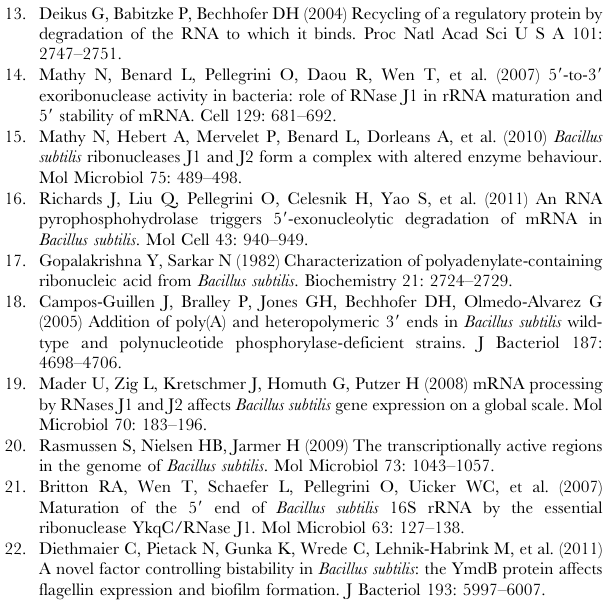
Table S5 Comparison with RNase Y substrates in Lehnik- Habrink study. Data sheets list candidate genes 2-fold and 1.5-fold greater than WT (‘‘2 6 up’’ and ‘‘1.5 6 up’’, respectively) and 2- fold and 1.5-fold decreased compared to WT (‘‘2 6 -down’’ and